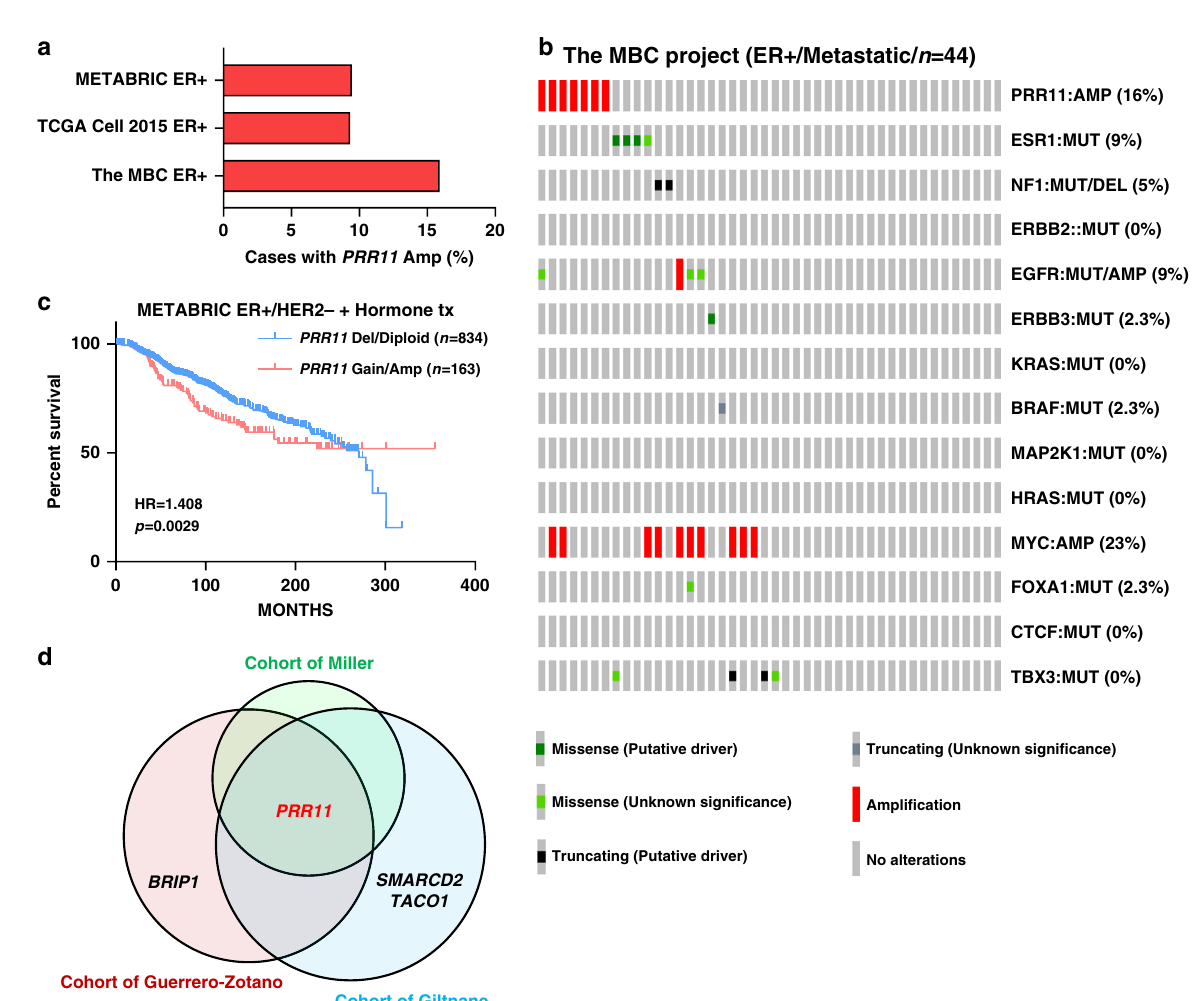
Fig. 2 PRR11 is a key gene in 17q23 associated with endocrine resistance. a Frequency of PRR11 ampli fi cation in MBC project, TCGA or METABRIC ER + breast cancers. b Oncoprint of putative endocrine-resistant drivers in metastatic ER + tumors from MBC project dataset. ER + tumors classi fi ed as ‘ METASTATIC DISEASE PRESENT ’ were interrogated ( n = 44). c Plot of disease-free survival of METABRIC ER + /HER2 − breast cancer patients treated with anti-hormone therapy as a function of PRR11 copy number [gain/ampli fi cation ( n = 163) vs. diploid/deletion (n = 834)]. d Venn diagram of genes in 17q23 that signi fi cantly correlated with on-treatment Ki67 levels (Pearson r > 0.4; p < 0.05). Source data are provided as a Source data fi treatment with endocrine therapy, so metastatic ER + tumors ampli fi cation predicted shorter disease-free survival of patients often harbor somatic alterations associated with endocrine with ER + /HER2 − breast cancer treated with antiestrogens (HR = 1.408; 95% CI, 1.029 – 1.926; Fig. 2c). Also in METABRIC, resistance. In ER + tumors in the MBC project dataset, PRR11 ampli fi cation was mutually exclusive with mutations in ESR1 and PRR11 copy number alterations (CNAs) were correlated with NF1 , both established mechanisms of antiestrogen resistance PRR11 mRNA expression (Supplementary Fig. 2b). In a panel of (Fig. 2b). In the METABRIC cohort, PRR11 copy number gain or 56 breast cancer cell lines in the CCLE dataset 24 , high PRR11